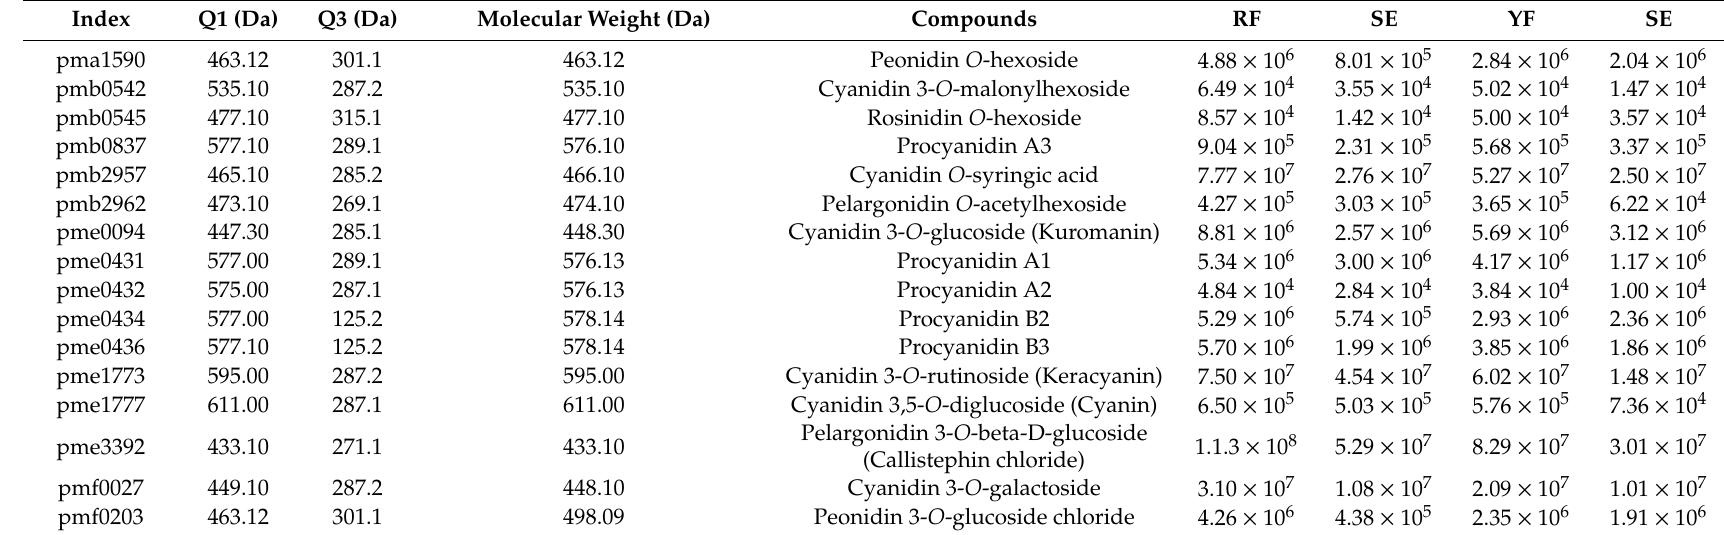
Table 1. Type and content of anthocyanins in RF and